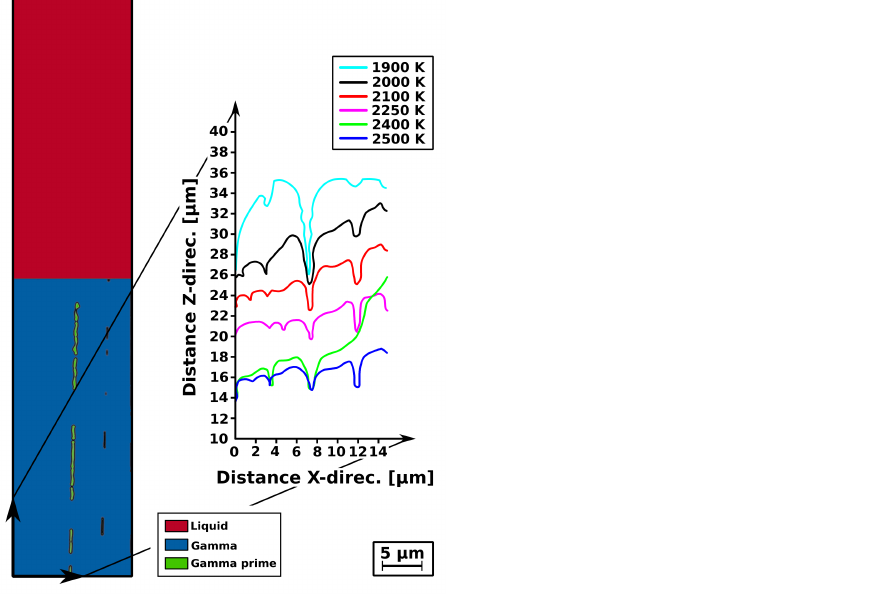
Figure 6. Correlation between the temperature of the current (liquid) built layer and the position of the interface from the remelted